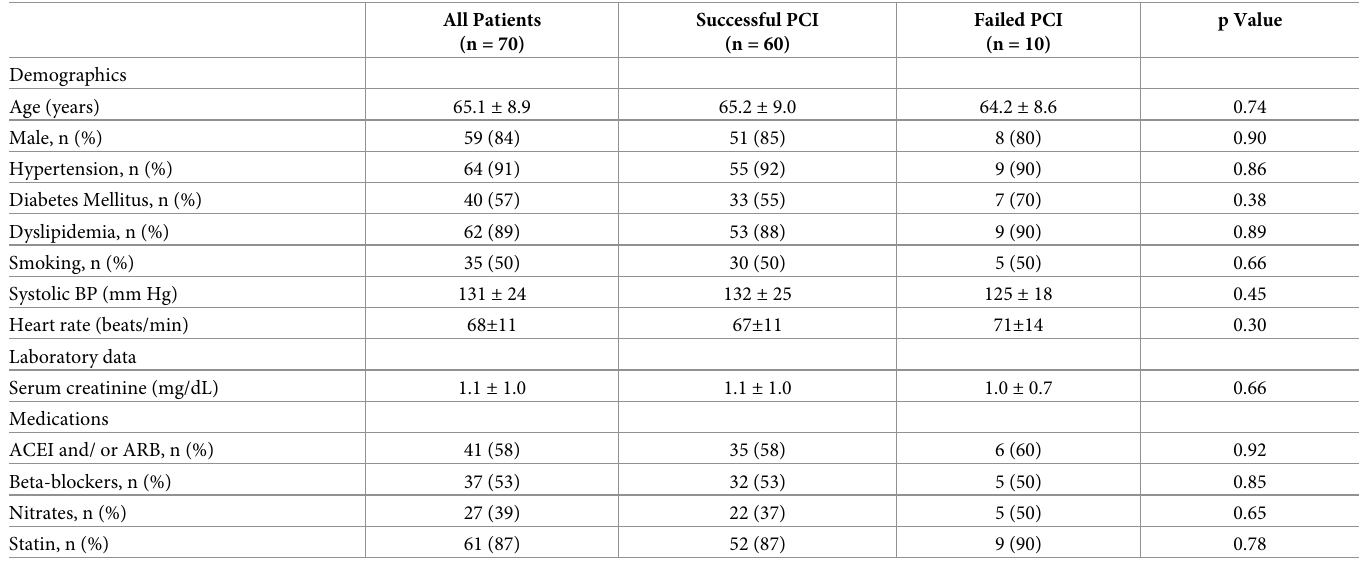
Table 1. Patient baseline